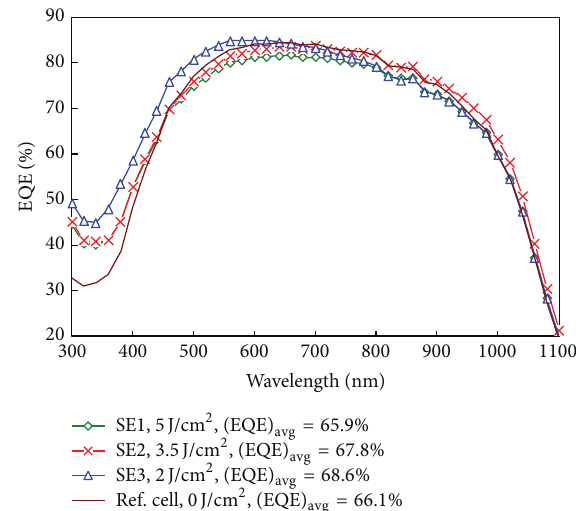
Figure 5: Comparison of EQE for SE mc-Si solar cells SE1–SE3 with different laser fluences and Ref. cell without laser